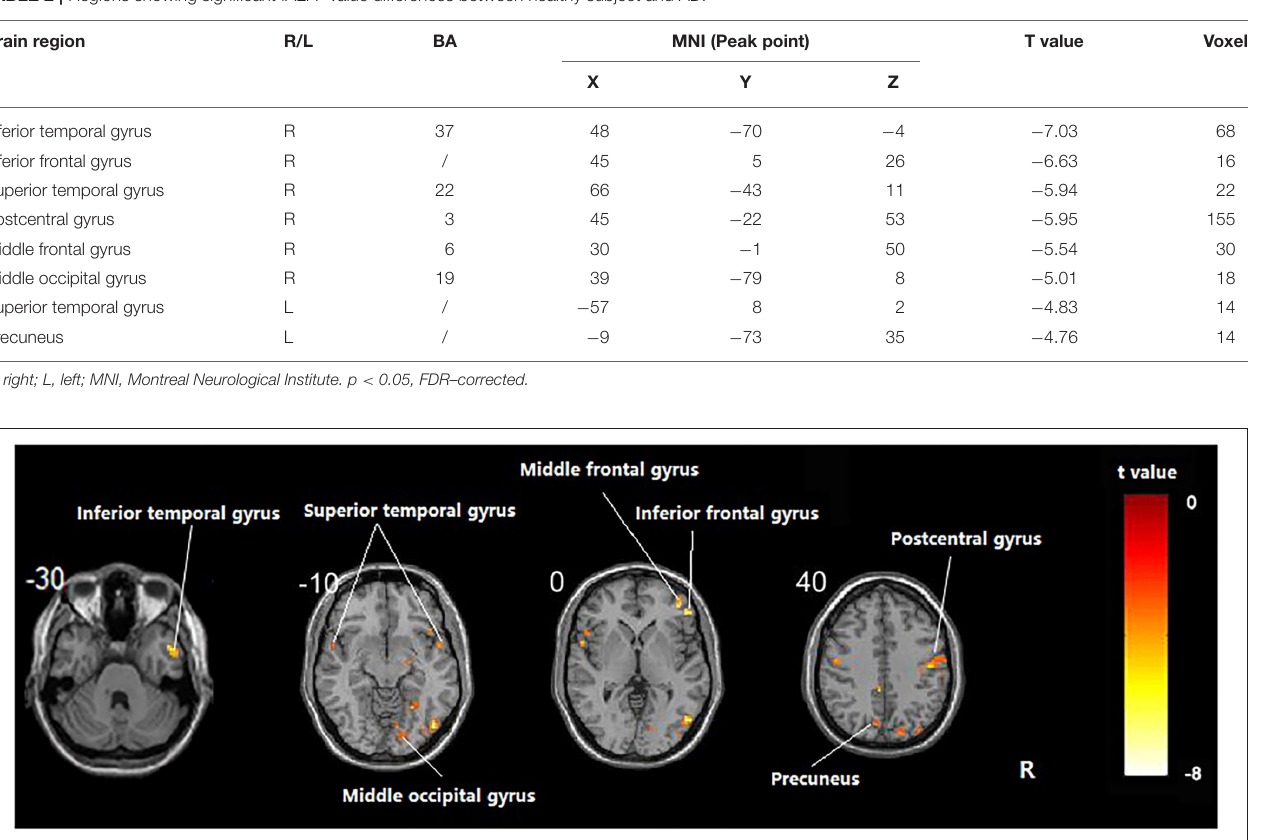
TABLE 2 | Regions showing significant fALFF value differences between healthy subject and AD.